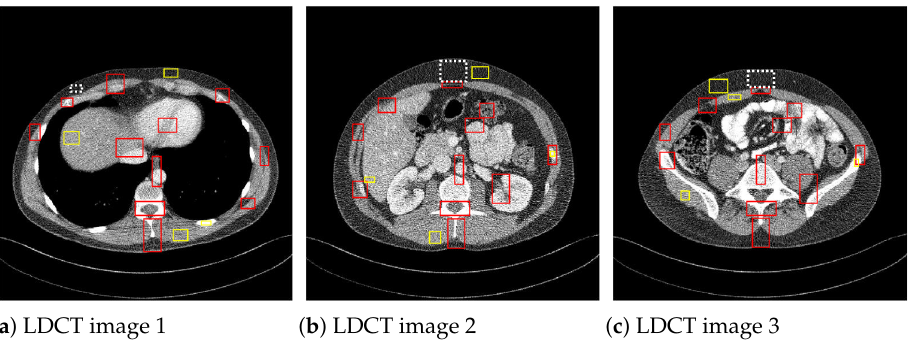
Figure 5. ROIs considered to compute CNR and ENL